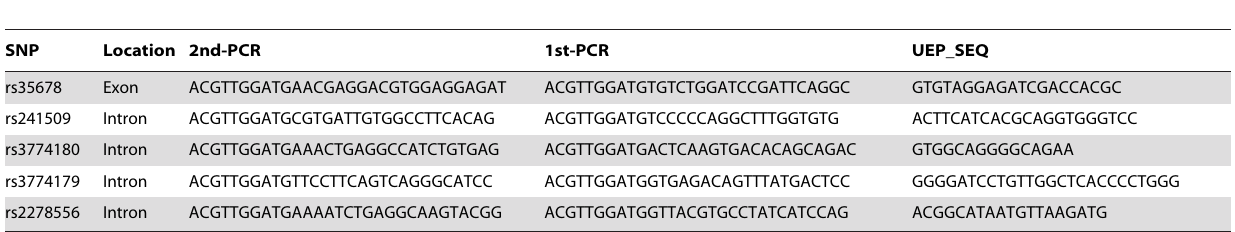
Table 1. The information of SNPs in ATP2B2 and primers of PCR and unextended primers for Sequenom SNP genotyping.